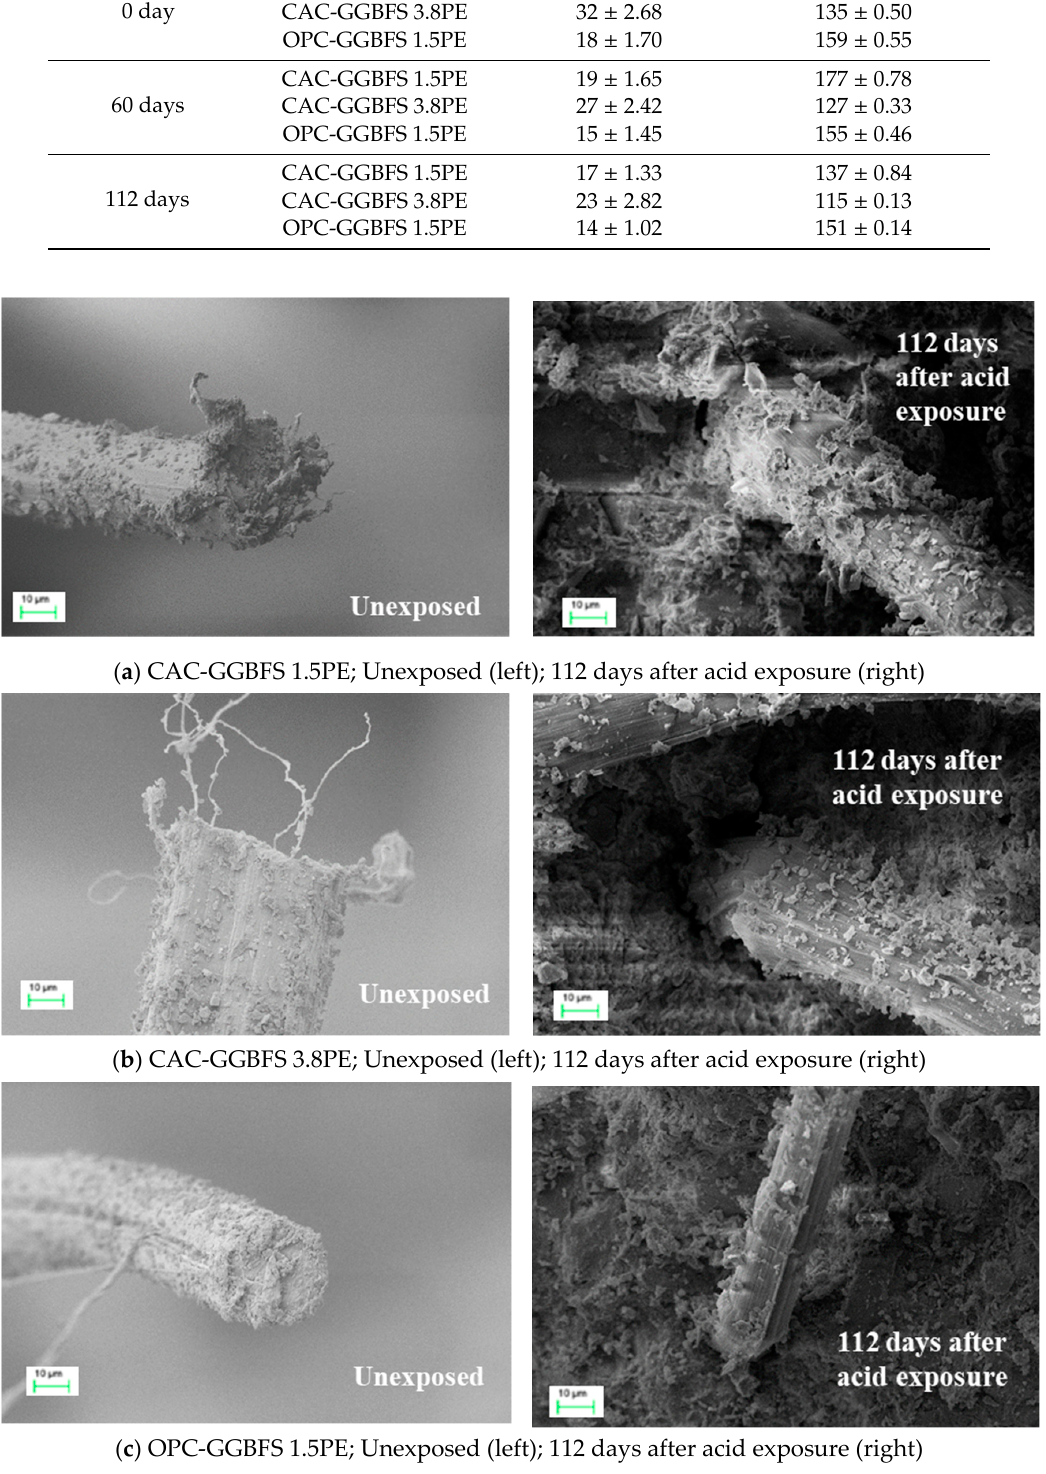
Figure 13. SEM images of PE fibre surface morphology before and 112 days after acid exposure [17]; (a ) PE fibre surface morphology (CAC-GGBFS 1.5PE); ( b ) PE fibre surface morphology (CAC-GGBFS 3.8PE); ( c ) PE fibre surface morphology (OPC-GGBFS 1.5PE). ( c ) PE fibre surface morphology (OPC-GGBFS